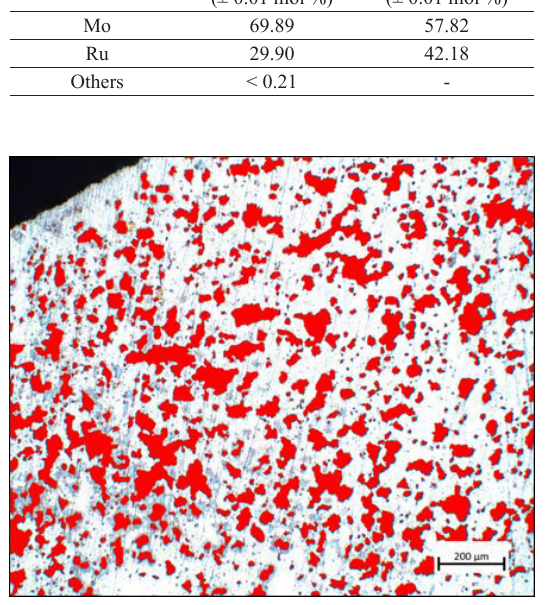
Table 5. EDX analysis of the Mo-Ru alloy surface before and after the melting process. Element